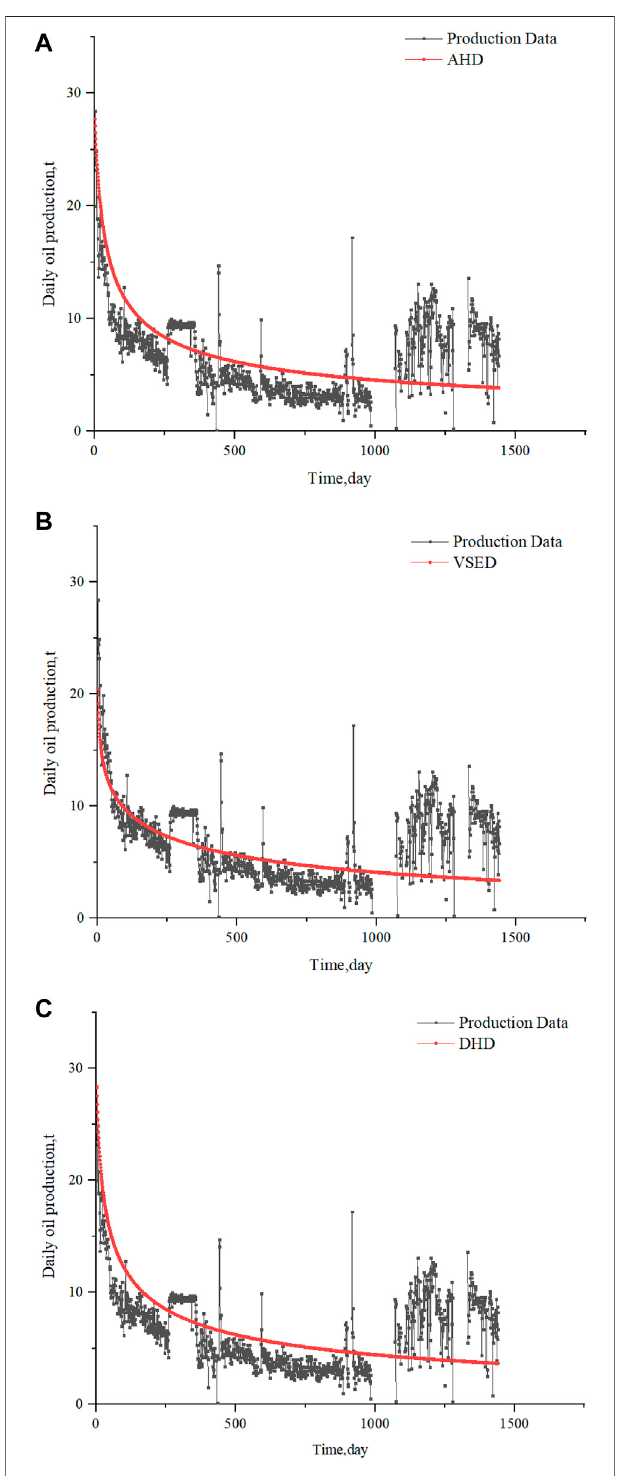
FIGURE 12 | Three decreasing fi tting curves of Well JI36_H: (A) AHD fi ttingcurveofWellJI36_H, (B) VSED fi ttingcurveofWellJI36_H,and (C) DHD fi tting curve of Well